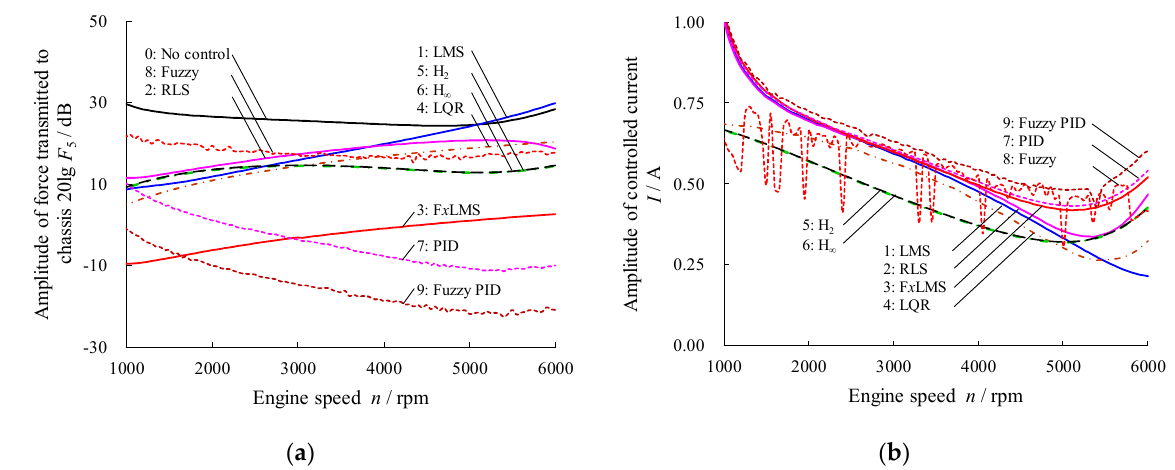
Figure 13. The force transmitted to the chassis and the control current at different engine speeds under nine control algorithms: ( a ) The force transmitted to the chassis; ( b ) The control current.